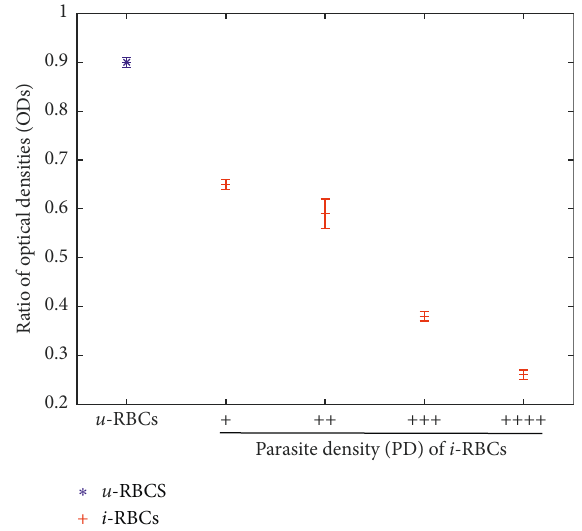
Figure 1: Optical densities ratio measured at blood absorption bands for uninfected RBCs ( u -RBCs) and Plasmodium falcipar- um -infected RBCs ( i -RBCs) of different parasite density (PD) (+), (++), (+++), and